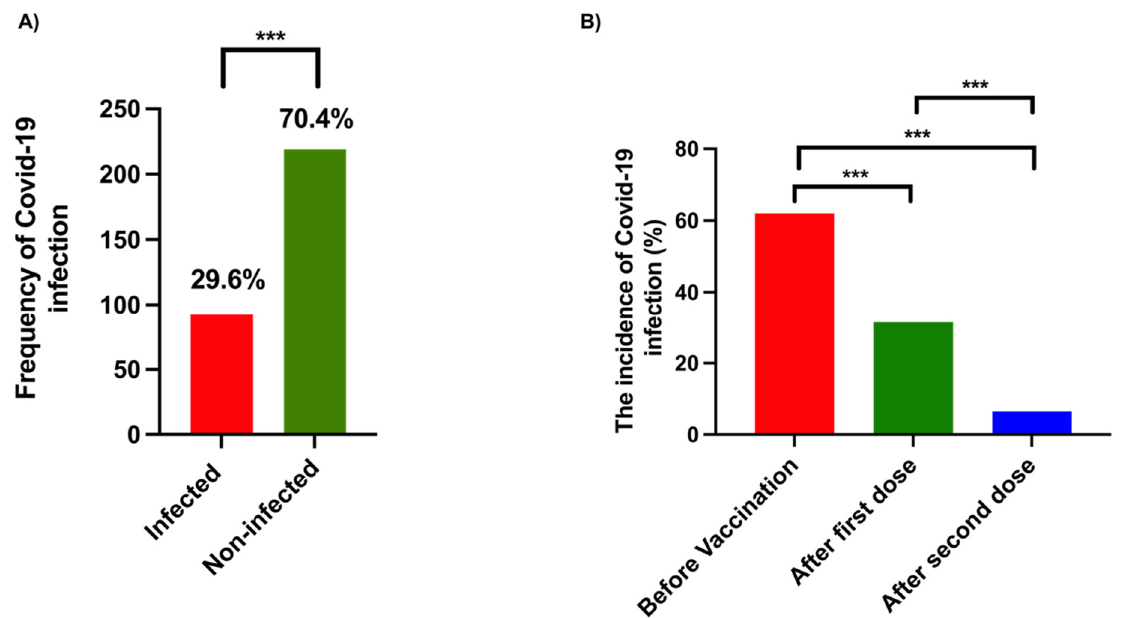
Figure 1. The frequency and incidence of COVID-19 infection within this study. ( A ) The total number of participants was 311 people, in which the frequency of infected people with COVID-19 was 92 (29.6%), and non-infected people was 219 (70.4) before the vaccination system started in Saudi Arabia. ( B ) The incidence of COVID-19 infection among participants in this study, regarding the frequency of infected people before the vaccination system, was 57 (62%), while after the first dose it was 29 (31.5%) and after the second dose it was 6 (6.5%). Statistical analysis was performed using the chi-square test. *** p < 0.001.